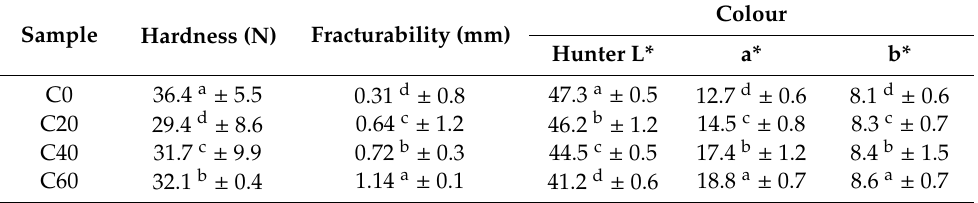
Table 7. Texture and colour of cookies fortified with sorghum–termite blend.